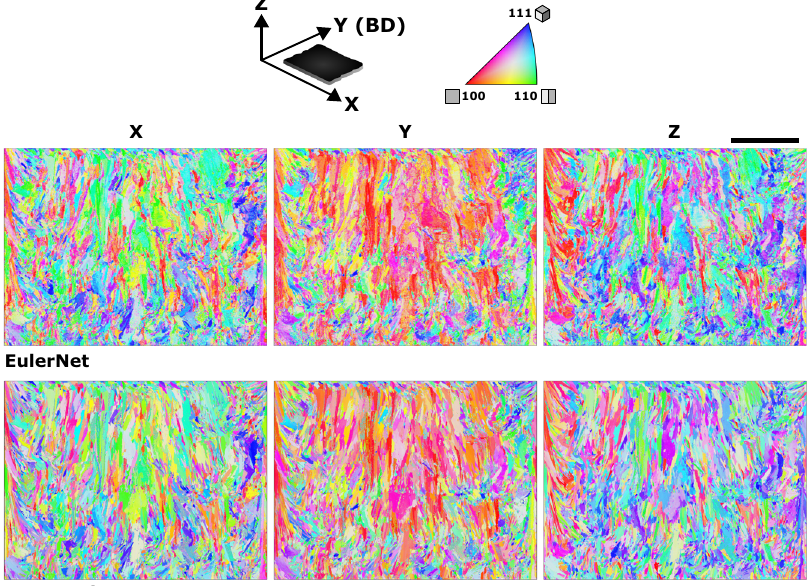
Fig. 3 Orientation maps produced by EulerNet (DRM) and EBSD. The IPF maps produced by our EulerNet model from directional re fl ectance are visually almost identical to the ground truth EBSD maps, both in-plane (along the X and Y reference directions) and out-of-plane (along the Z direction). The specimen shown in the fi gure was not used for training the model. The scale bar represents 5 mm.